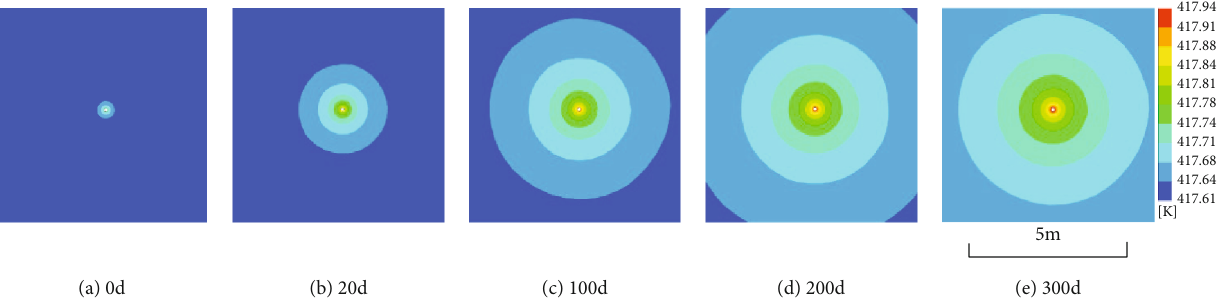
Figure 6: Temperature distribution of the formation around the well during production at 7000